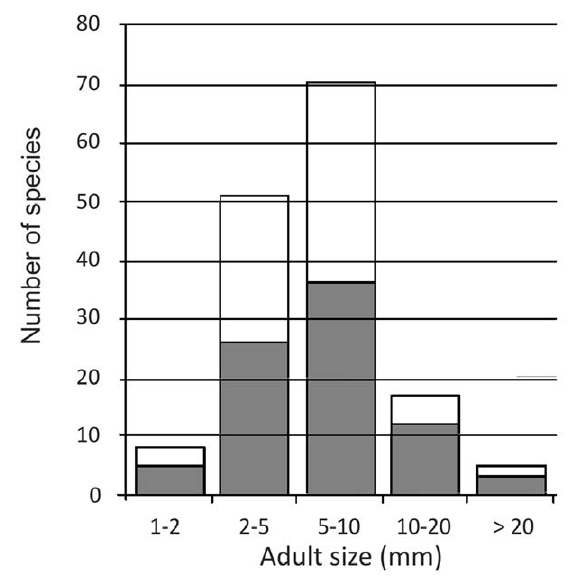
Fig. 8. – Histogram of size classes for the molluscan species repre- sented in haul BT04: (bars represent the total number, shaded por- tion represents live collected species). Only the largest size classes (above 10 mm) are expected to be represented in the shipboard